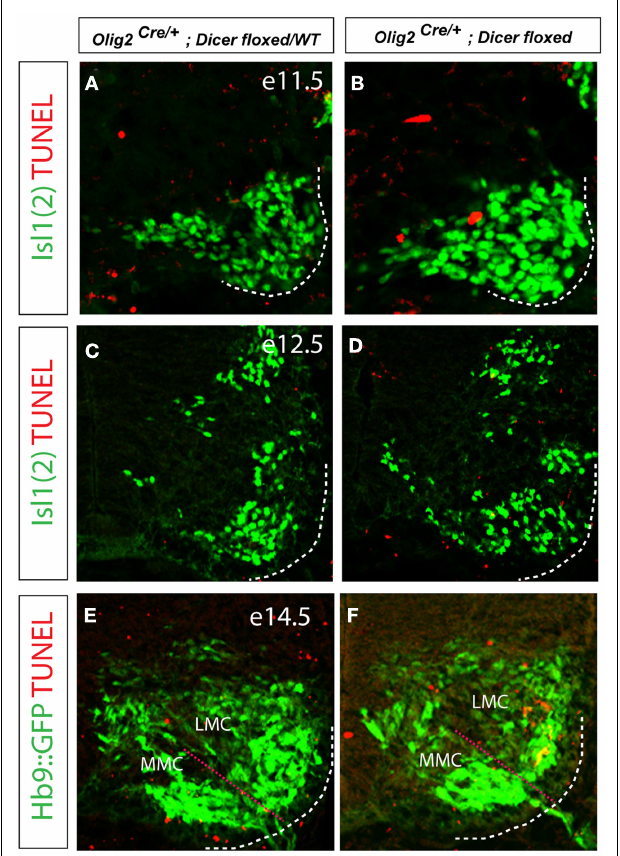
FIGURE 4 | Increased apoptosis is detected in E14.5 Dicer mutant LMC. (A–F) TUNEL labeling of fragmented apoptotic nuclei in the developing spinal cord at E11.5, 12.5, and E14.5.While the number ofTUNEL positive cells in the ventral spinal cord was overall low, we observed consistently higher number ofTUNEL positive nuclei within the LMC (Isl1 positive) of conditional Dicer KO embryos on day E14.5 (E,F) .